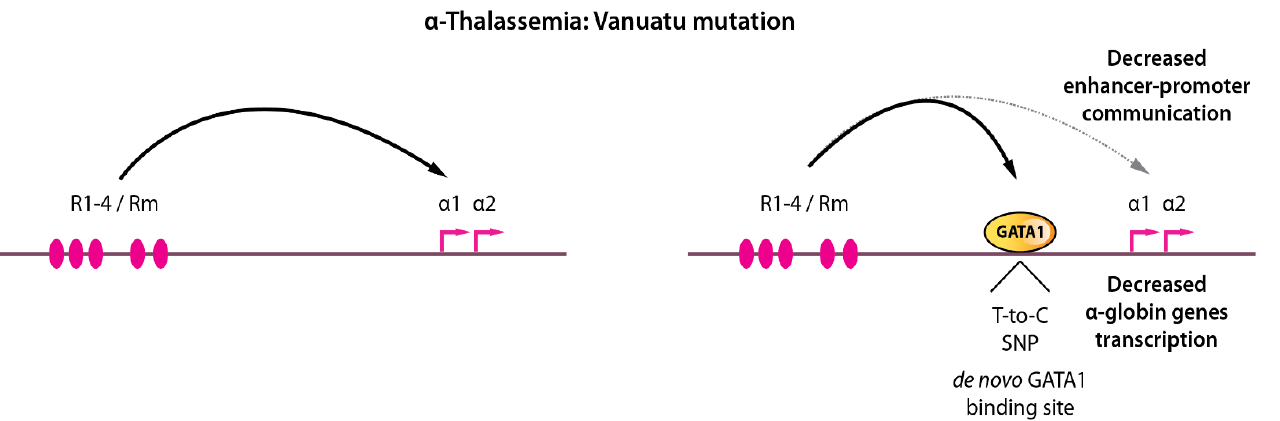
Figure 7. A single base-pair change in a non-coding region leads to α -thalassemia by modifying long-range enhancer-promoter contacts. Left, the α -globin locus is depicted with enhancer-promoter communications. Right, a single T-to-C single nucleotide polymorphism creates a de novo GATA1 binding motif, GATA1 recruitment, and partial rewiring of long-range chromatin contacts leading to decreased -globin expression resulting in thalassemia.